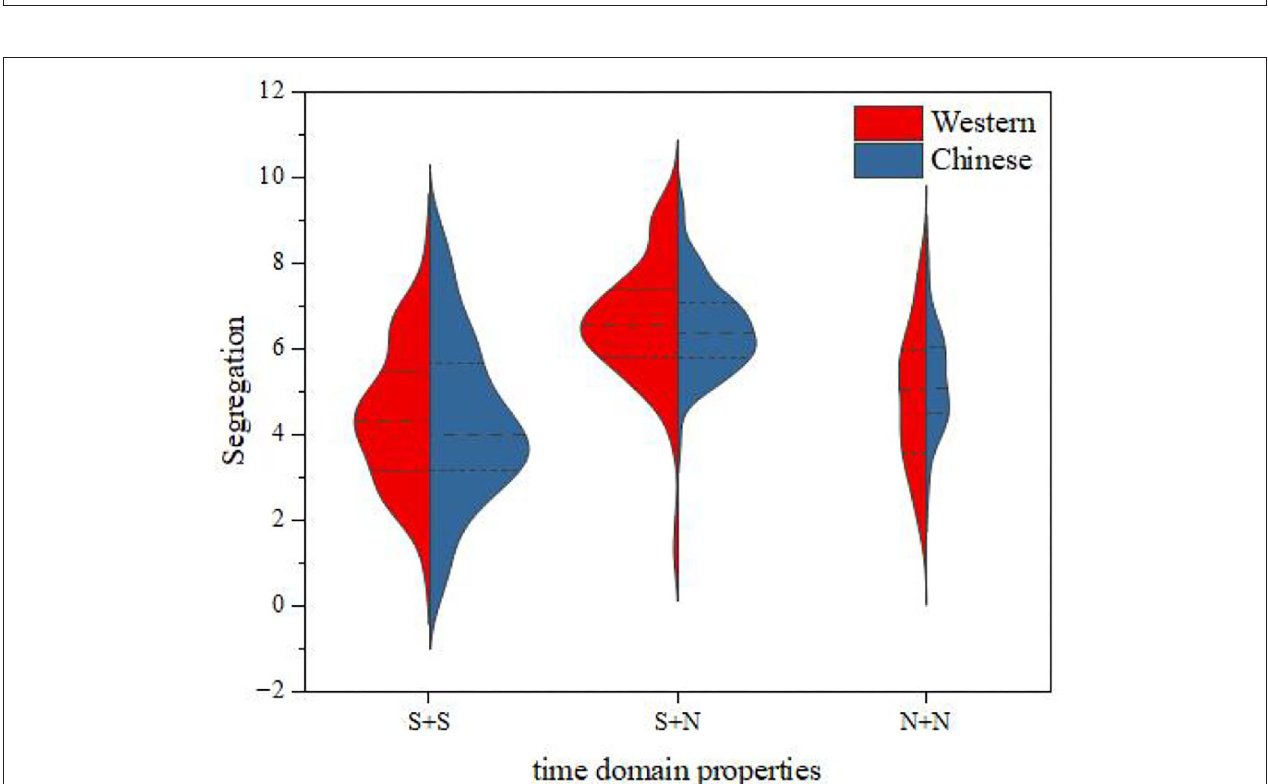
FIGURE 11 | Segregation comparisons between Western and Chinese